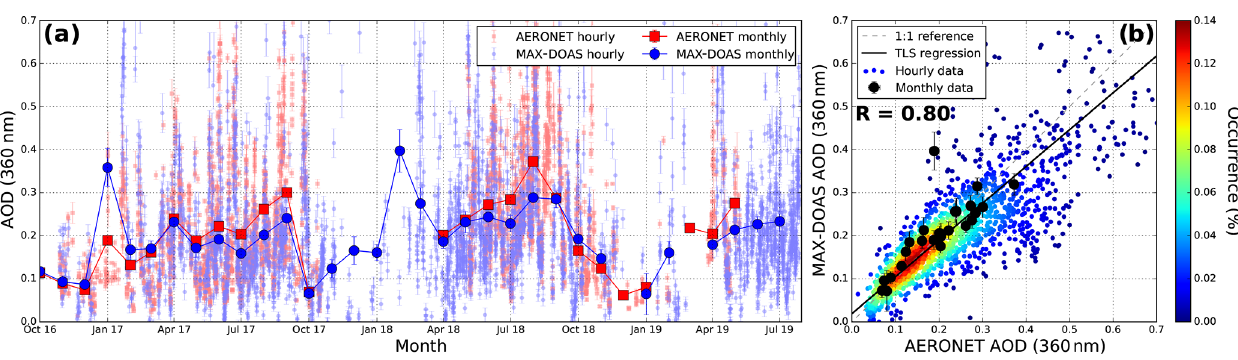
Figure 8. (a) Time series of aerosol optical depth measured by MAX-DOAS (blue curve) and sun photometer (red curve). (b) Scatterplot of aerosol optical depth measured by MAX-DOAS and sun photometer. The correlation coefficient and total least squares regression line are calculated based on the hourly averaged